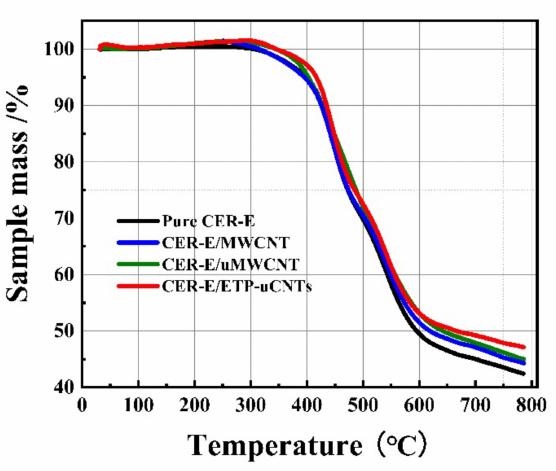
Figure 4. TGA curve of hybrid nanocomposites for the pure CER-E, CER-E/MWCNTs, CER- E/uMWCNTs and CER-E/ETP-uCNTs with filler content of 0.8